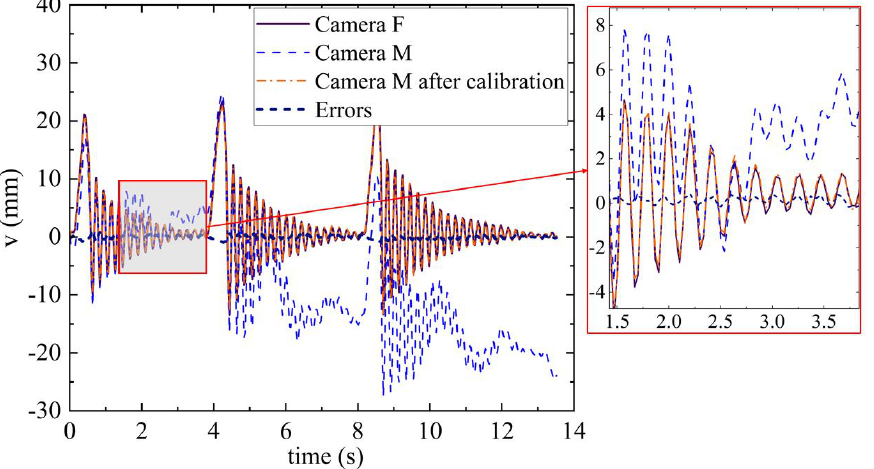
Figure 13. Displacement time – history curve.